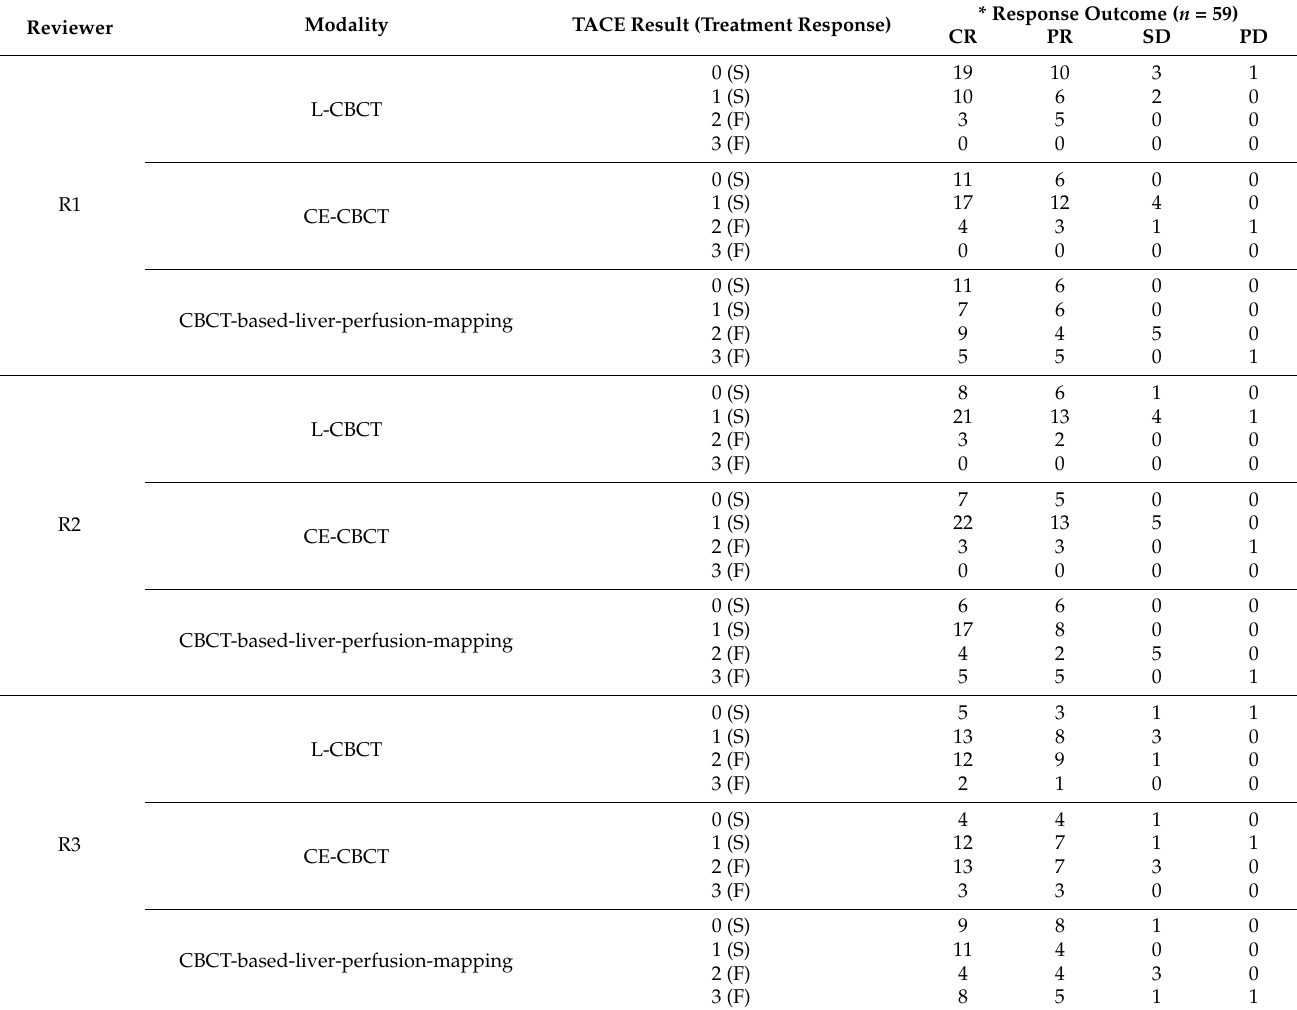
Table 2. Correlation between treatment response on imaging modalities after transarterial chemoembolization for hepato- cellular carcinoma and response outcomes on follow-up CT or MRI.